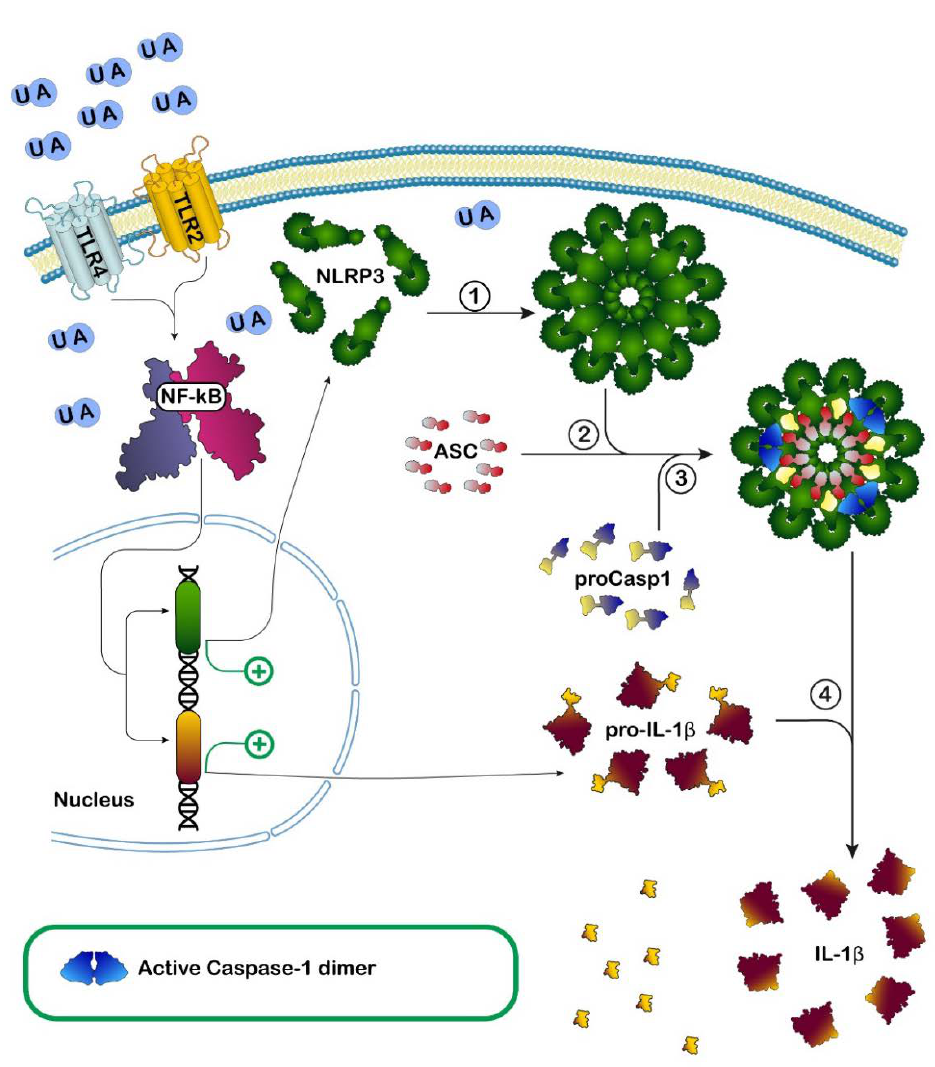
Figure 5. Effect of uric acid (UA) on inflammation. Proposed model in which Toll-like receptors 2 and 4 (TLR2, TLR4) signaling mediates induction of inflammation by both intracellular and extracellular UA crystals. In this model, based on the results of several studies, UA engages TLR2 and TLR4 receptors causing activation of the transcription factor nuclear factor kappa-light-chain-enhancer of activated B cells (NF-kB), which, in turn, promotes the increase in both Nod-like receptor family pyrin domain containing 3 (NLRP3) and pro-interleukin-1-beta (pro-IL-1 β ) synthesis. Activation, caused by different signals including UA, promotes NLRP3 oligomerization (1), the growing oligomer recruits and binds apoptosis-associated speck-like protein containing a caspase recruitment domain (ASC) (2), which subsequently recruits and binds pro-caspase-1 (proCasp1) (3). The activation and formation of NLRP3 inflammasome leads to auto-cleavage and formation of the active caspase-1 dimer which then proteolytically cleaves pro-IL-1 β to its bioactive form IL-1 β (4) prior to its release, thus starting the inflammatory